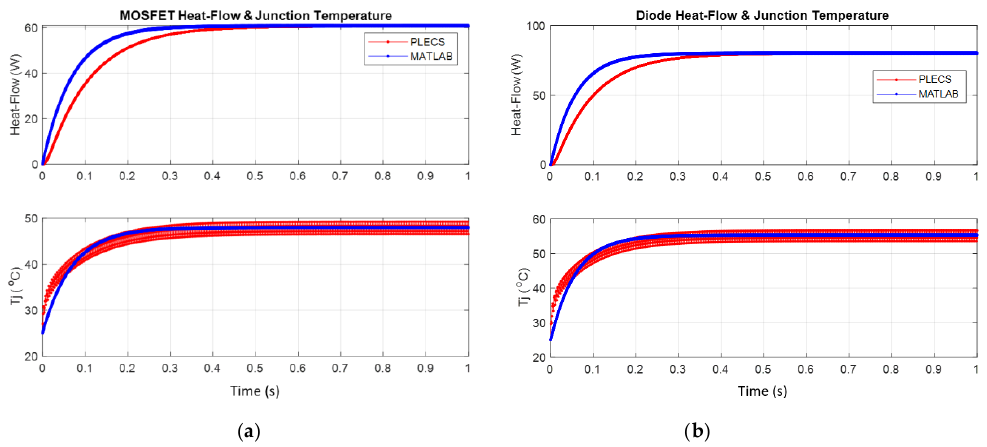
Figure 23. Thermal model PLECS validation of ( a ) MOSFET, ( b ) diode.